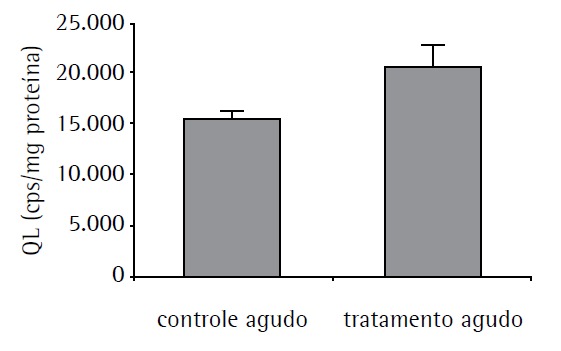
Média dos níveis de peroxidação lipídica nos pulmões de ratos submetidos
a administração aguda de metilprednisolona (grupo de tratamento agudo) ou
injeção de um volume igual de solução salina (grupo de controle agudo). QL:
quimioluminescência; e cps: contagens por segundo.